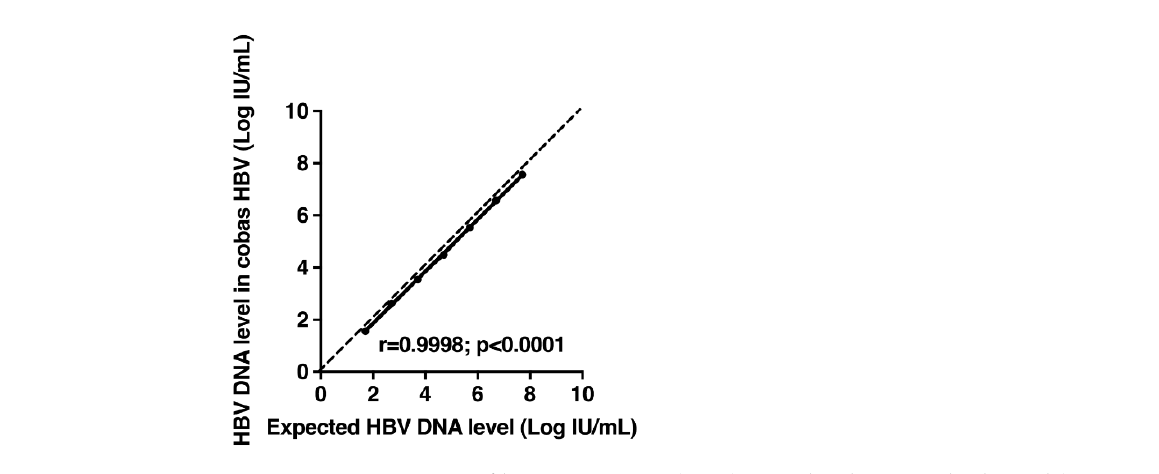
Figure 1. Measurements of hepatitis B virus (HBV) DNA levels in standard panel (AcroMetrix™ HBV Panel; Thermo Scientific, Fremont, CA, USA) containing different concentrations of HBV DNA with the cobas ® HBV Test. The average measured values are shown as a function of the expected values. The dashed line represents the equality line.